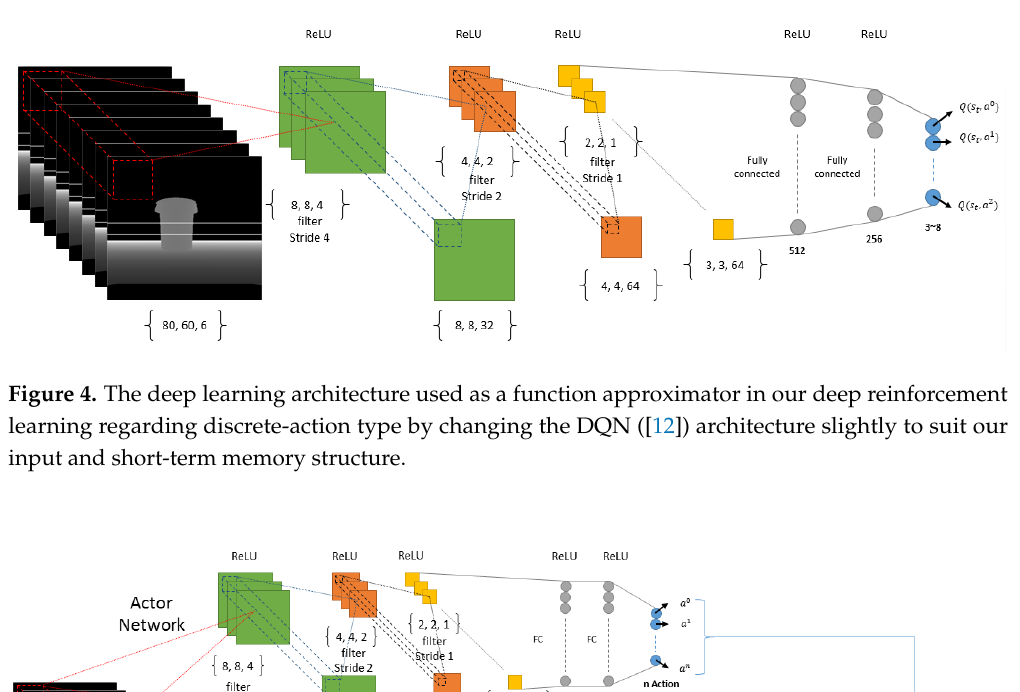
Figure 5. Finally we used memory-reply mechanism [18] for optimal training of our DNNs.